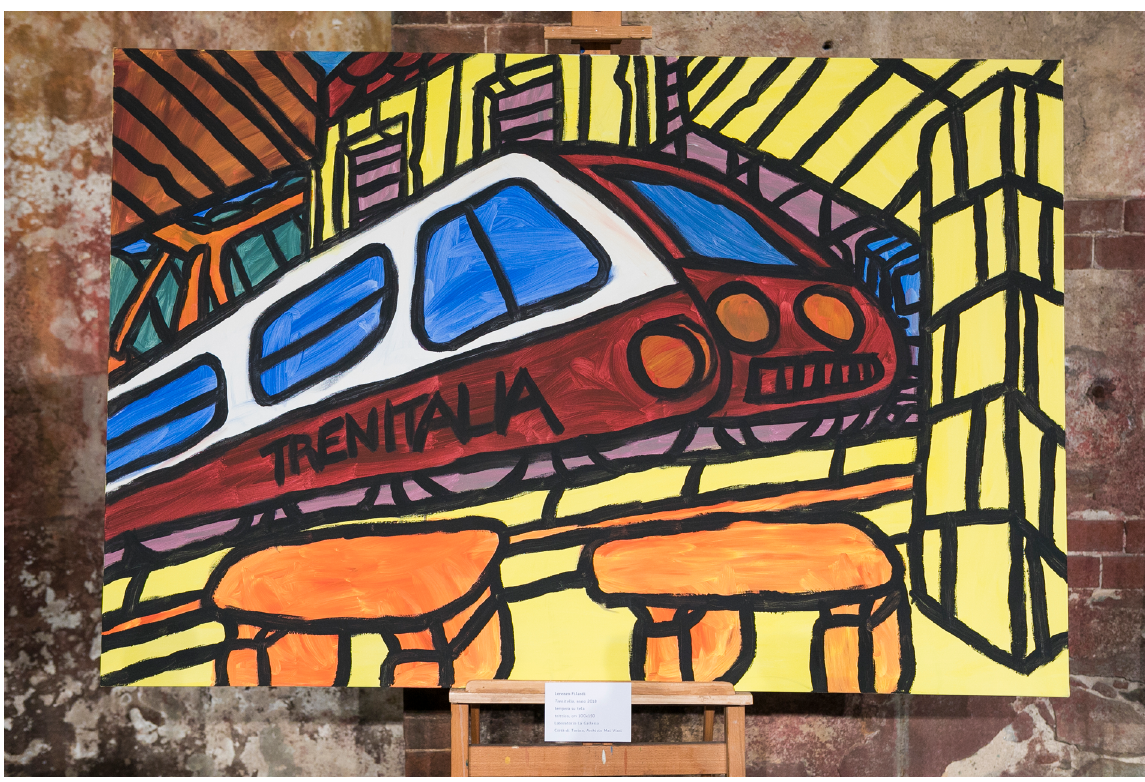
Lorenzo Filardi, Trenitalia,